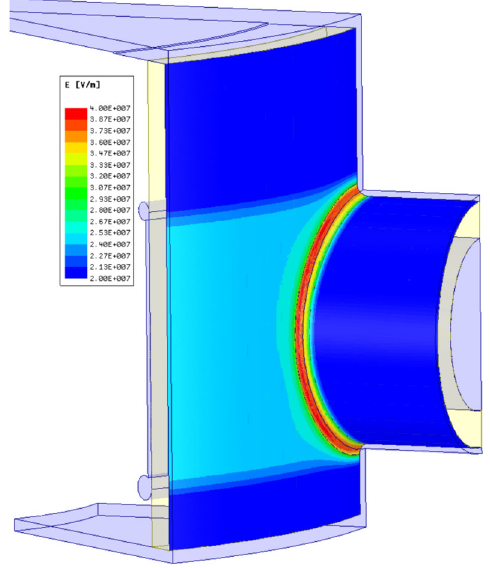
FIG. 4. Plot of electric fields contour on the induction cell shell. The maximum electric field is around the feed port which is about 400 . 0 kV =